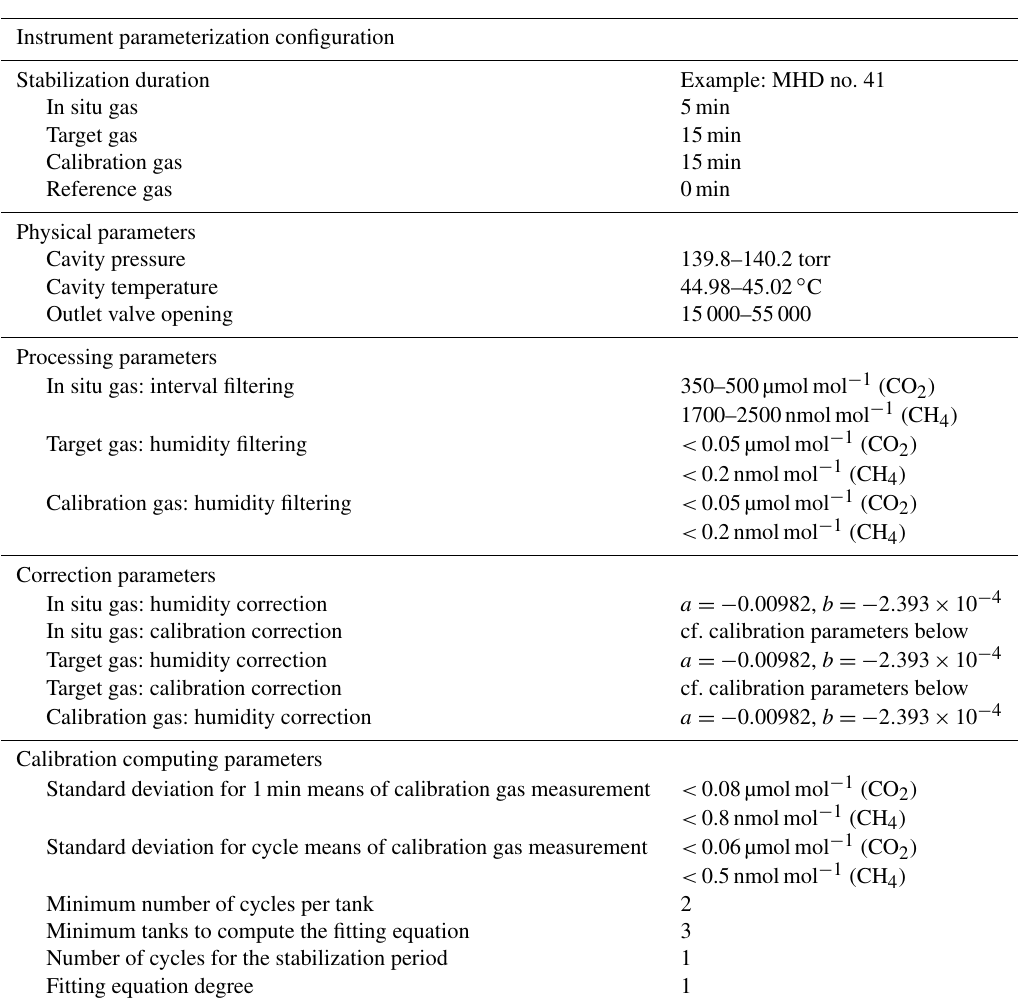
Table 4. List of the parameters used for the automatic processing of CO 2 and CH 4 mole fractions by CRDS analyzers. The humidity filtering applied to the tank measurements consists of checking the absolute difference between the wet value and the computed dry value against the defined threshold. The parameters are specific to the instrument